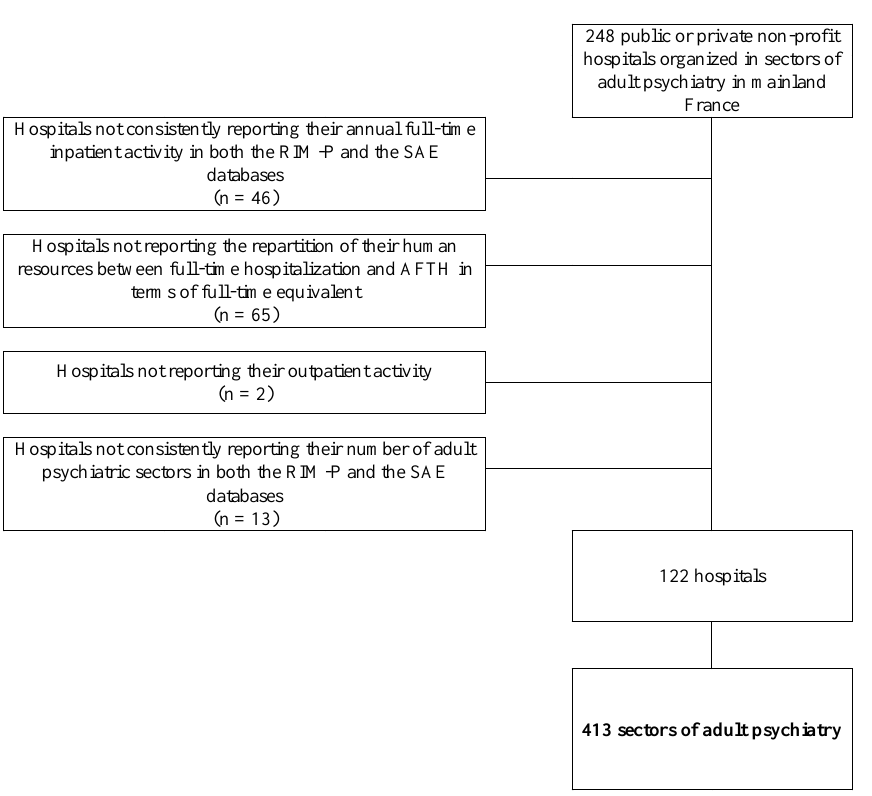
Figure 1. Flowchart for the selection of included sectors based on data quality.